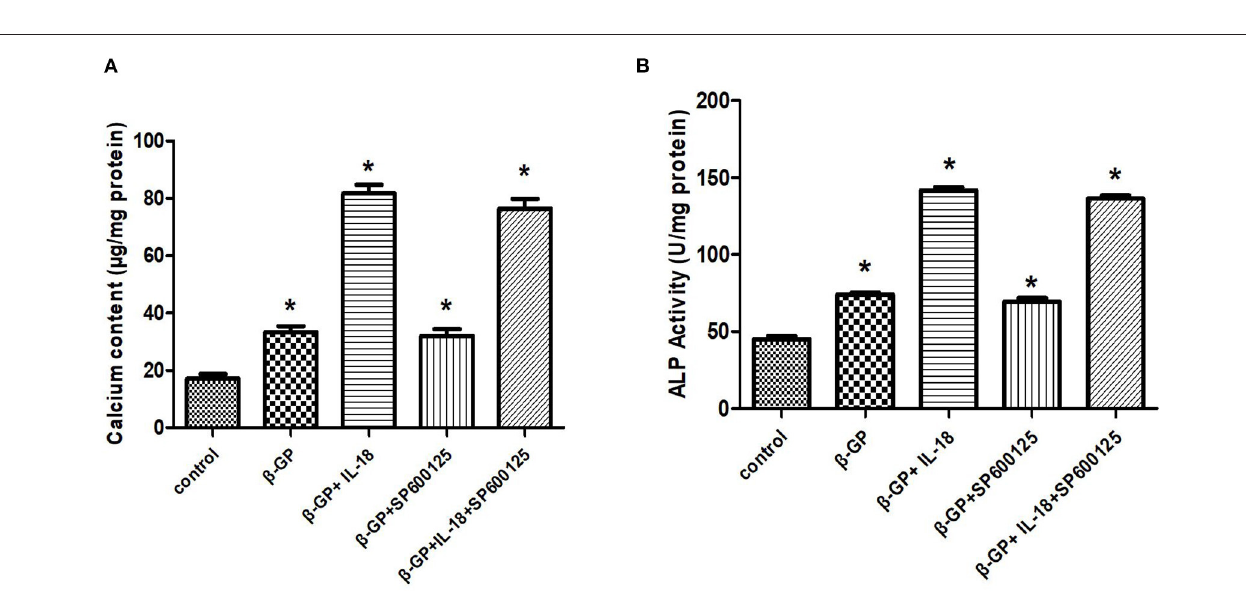
FIGURE 12 | Effect of JNK pathway on IL-18-induced calcification of rat VSMCs. (A) Effect of JNK pathway on calcium content of rat VSMCs after IL-18 intervention. (B) Effect of JNK pathway on ALP activity of rat VSMCs after IL-18 intervention. Rat VSMCs were pre-incubated with JNK inhibitor SP600125 (10 µ mol/L) for 30min, and then treated with β -GP (10 mmol/L) or IL-18 (100ng/ml) + β -GP (10 mmol/L) for 14 days, respectively. The experiment was repeated 3 times independently. * P < 0.01 vs. control group. ALP, alkaline phosphatase; BMP-2, bone morphogenetic protein-2; β -GP, β -glycerol